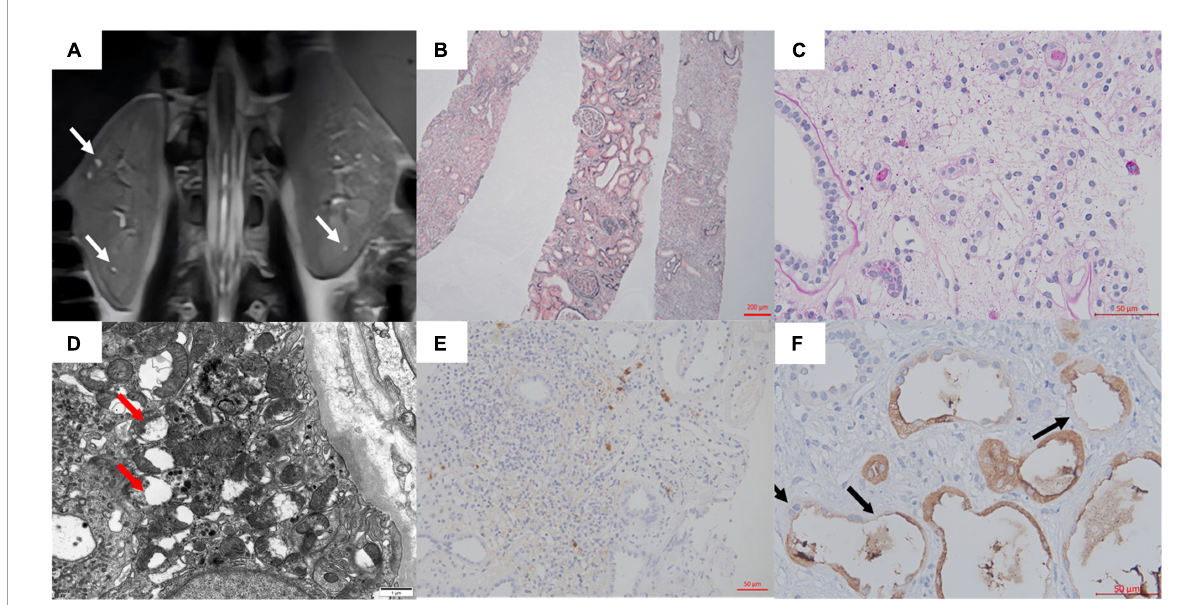
FIGURE1 (A) MRI showed multiple microscopic cysts in the medulla of the patient’s kidney. (B,C) Interstitial edema and tubular destruction (PAS 400 × ). (D) Transmission electron micrograph of tubular epithelial cytoplasm showed mitochondrial swelling, focal cristae damage, and vacuolation (arrows). (E) The IgG4 staining in the interstitium. (F) Uromodulin was expressed in the cytoplasm of most cells of the thick ascending limb of Henle. Some epithelial cells were negative or weakly/partial UMOD positive along the luminal side (arrows). No UMOD protein accumulation was observed (400 ×